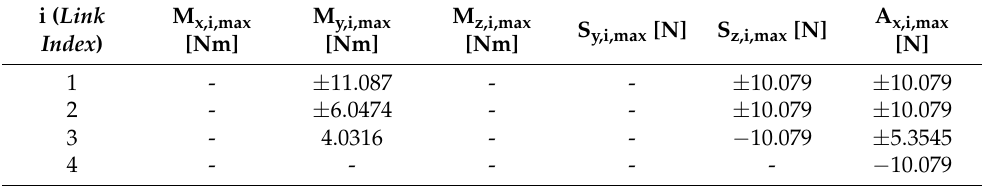
Table 3. Maximum non-null influence coefficients due to the unit moment M e,z (= 1 Nm) of case